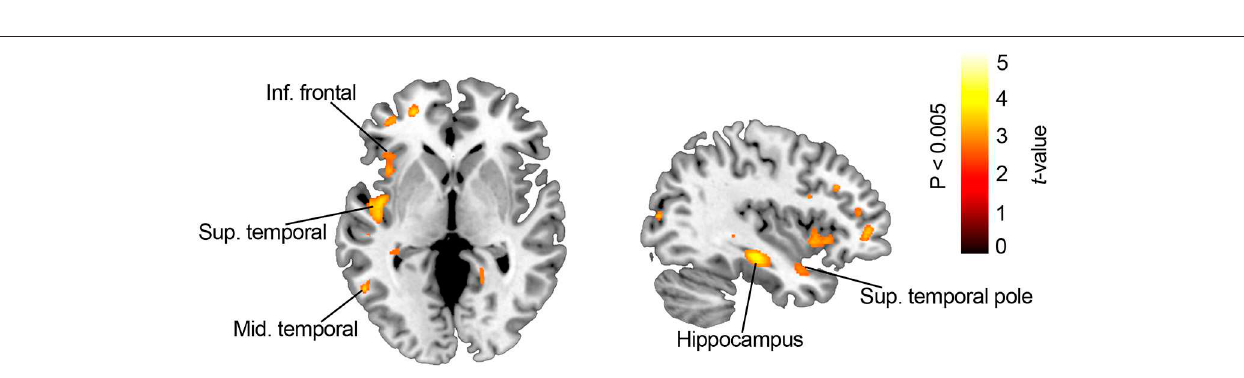
FIGURE 3 | Results of the voxelwise MD analysis. The slices show regions with significant MD increases in association with poorer FCSRT performance. For depiction purposes results are showed with a p < 0.005 (uncorrected) and k =